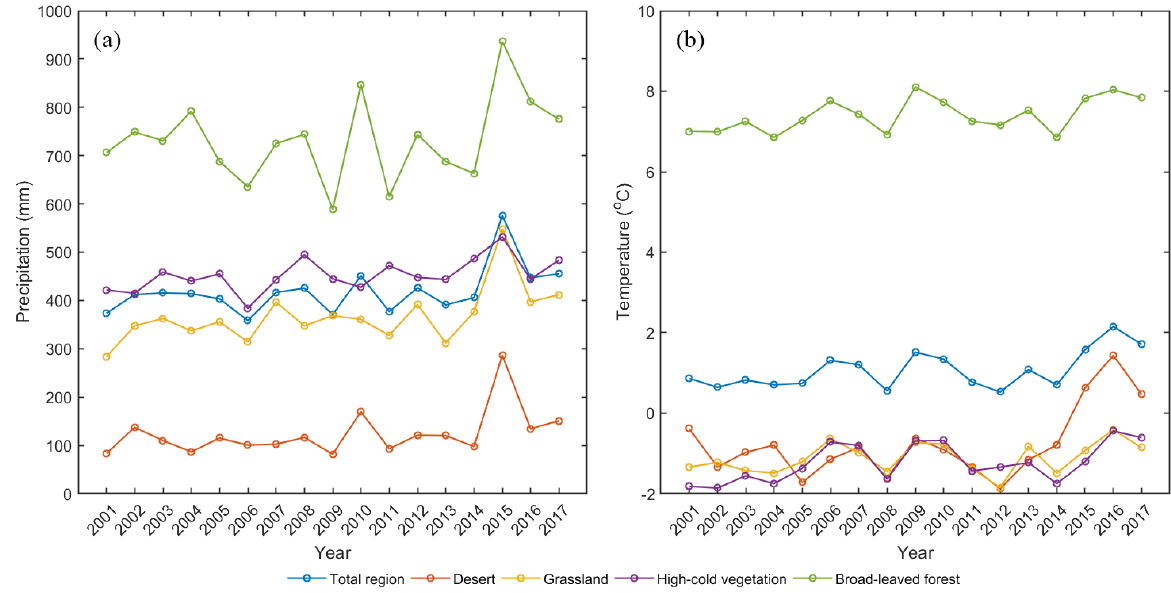
Figure 7. The interannual variation characteristics of ( a ) precipitation and ( b ) temperature in QTP during 2001–2017. Table 3. Trend analysis and mean value of precipitation on each region.